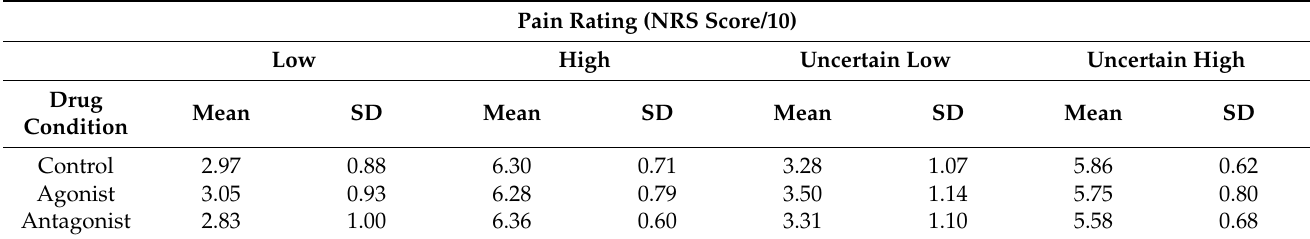
Table 1. Pain rating descriptive statistics. The ratings are separated into cue type and drug condition. Ratings are reported as mean and standard